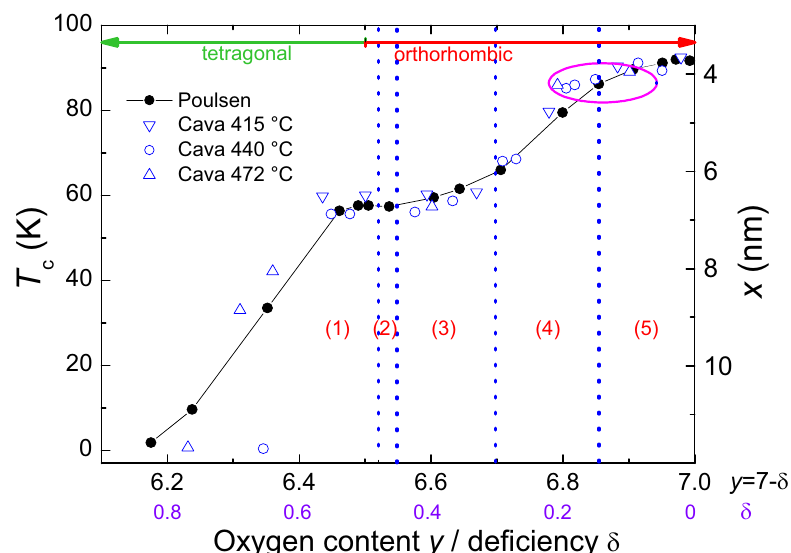
Figure 5. T c as function of the oxygen stoichiometry given as 7 − δ or the oxygen deficiency δ . The open blue symbols are experimental data from Cava et al. [47,48], the filled black dots are simulation data of Poulsen et al. [35]. The line is a guide for the eye. Five regions labeled (1)–(5) could be identified (see main text). The magenta ellipse marks the region where the δ T c -pinning may take place. Figure redrawn from Ref.